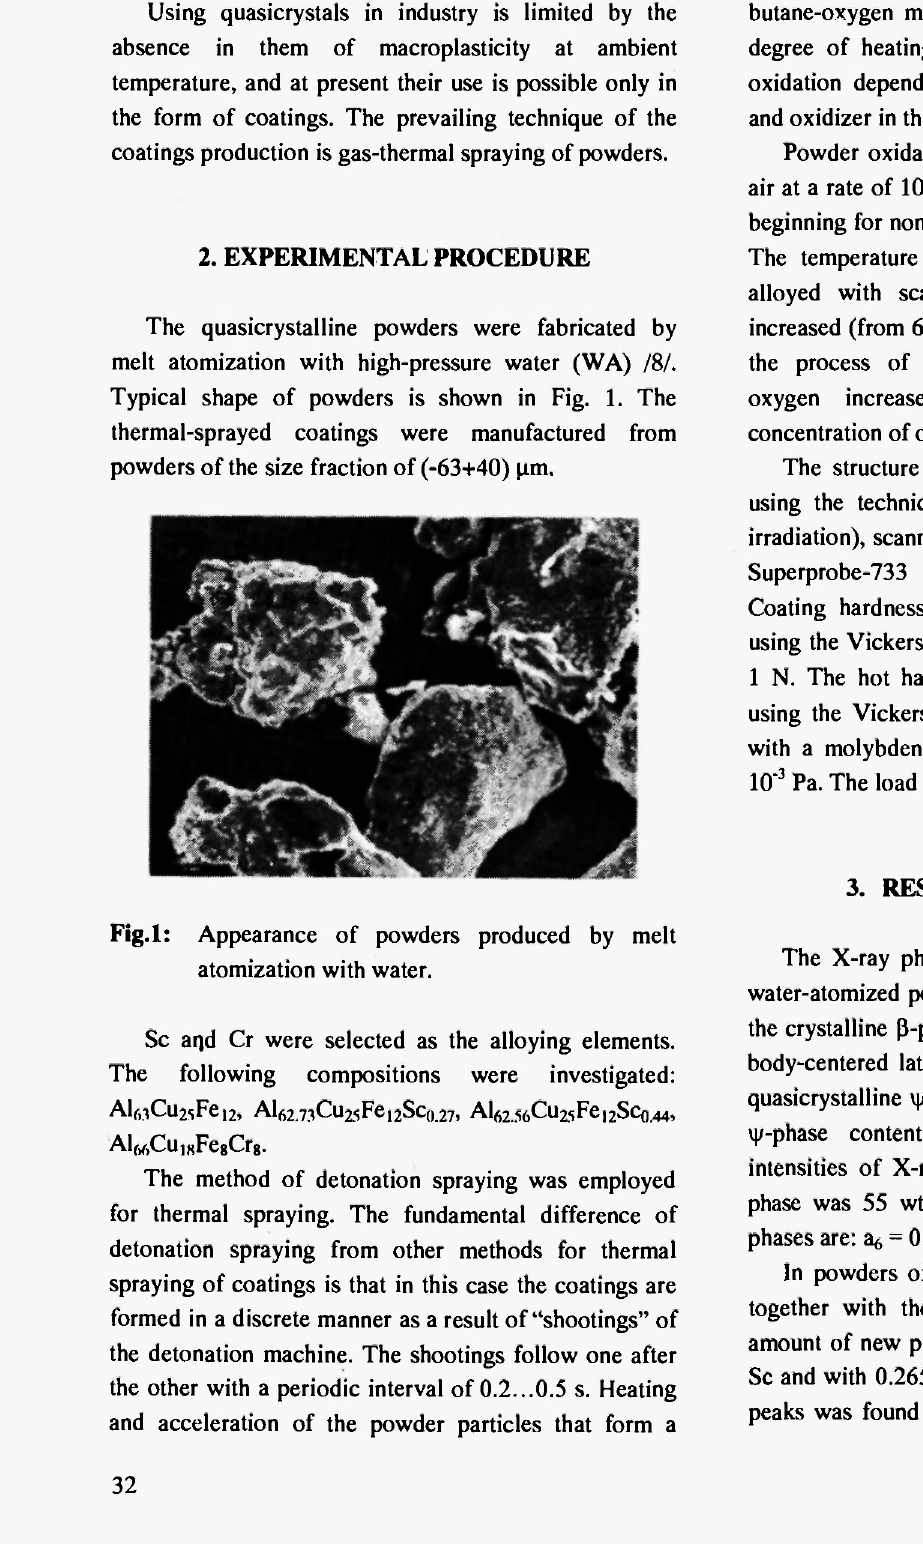
Fig.l: Appearance of powders produced by melt atomization with